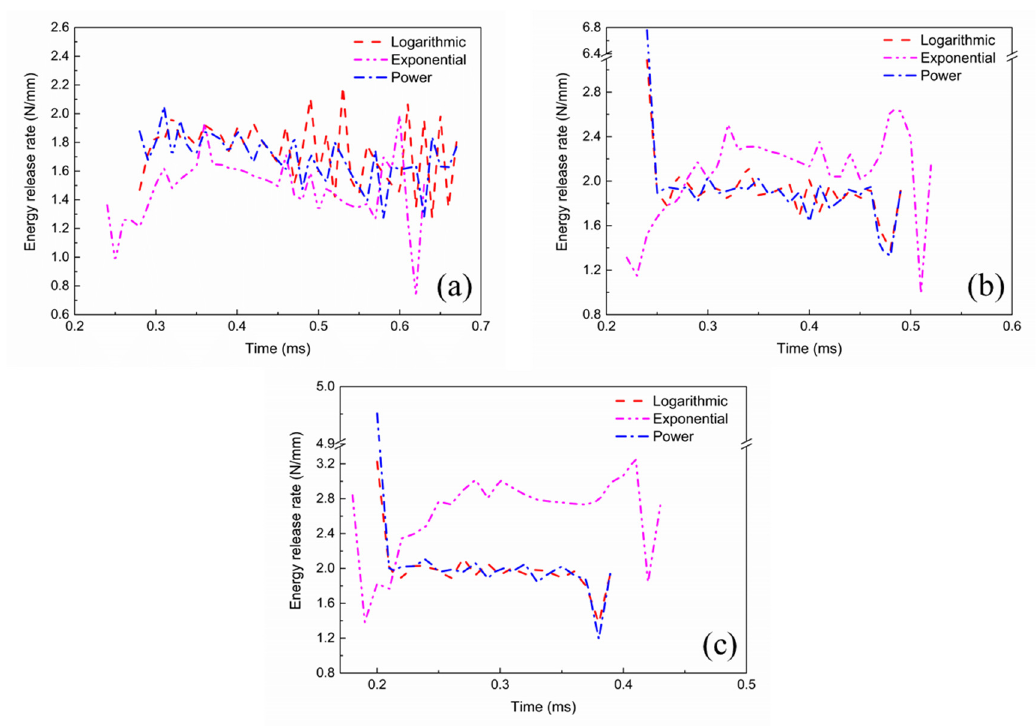
Figure 5. Energy release rate-time curves of crack tip speed of ( a ) 108, ( b ) 175, and ( c ) 253 m/s.